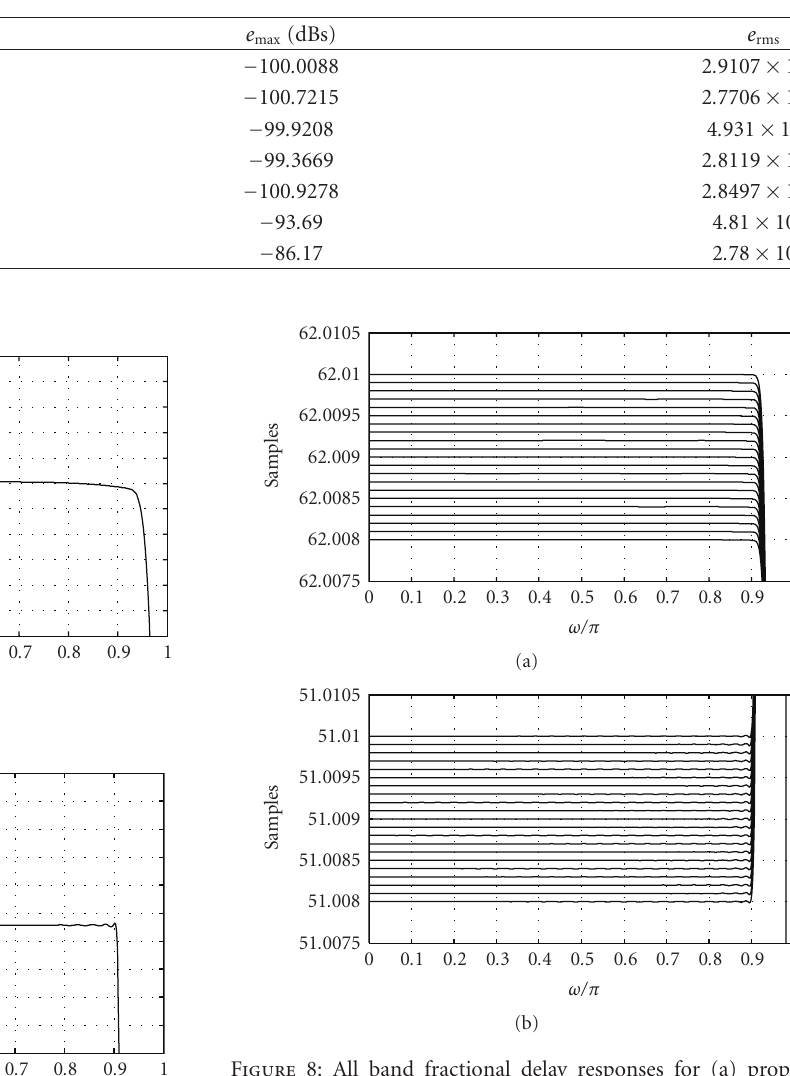
Table 1: Comparison of approximation errors for several methods.